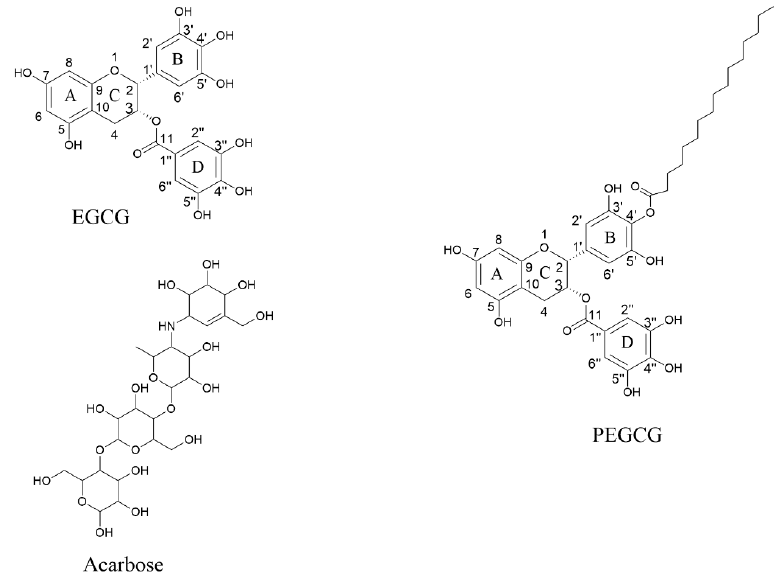
Figure 3. Chemical structure of the ligands from PubChem EGCG, PEGCG, and acarbose. Table 5. Inhibition of α-amylase and α-glucosidase.